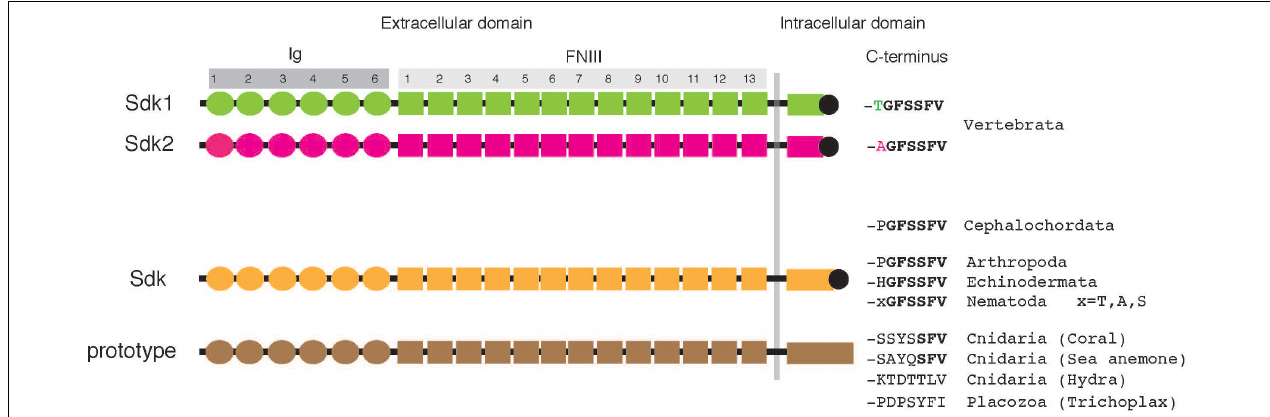
FIGURE 1 | Structure of Sdks. Each Sdk contains a signal sequence, 6 Ig domains (Ig), 13 fibronectin type III (FNIII) domains, a transmembrane domain, and a ∼ 200–400 amino acid cytoplasmic domain. Vertebrates have two Sdks (also see Table 1 ). The predicted lengths of typical human Sdk1, human Sdk2, and Drosophila Sdk are 2,213 amino acids, 2,172 amino acids, and 2,168 amino acids, respectively, although each Sdk protein with a cleavable N-terminal signal peptide is translated from spliced mRNA variants and potentially modified by glycosylation.